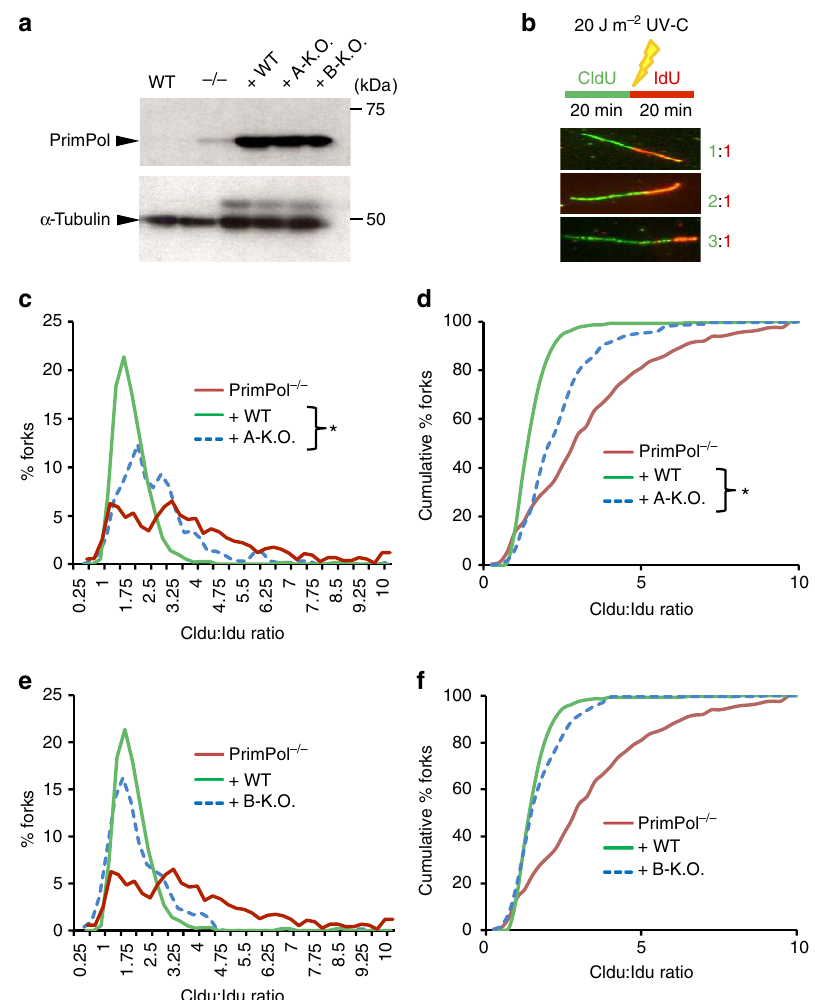
Figure 5 | RBM-A is required for PrimPol function in DNA replication restart. ( a ) PrimPol (cid:2) / (cid:2) DT40 cells were complemented with un-tagged human PrimPol constructs; wild-type hPrimPol ( þ WT), hPrimPol D519R/F522A ( þ A-KO) and hPrimPol D551R/I554A ( þ B-KO). ‘WT’ indicates lysate from wild-type DT40 cells, ‘ (cid:2) / (cid:2) ‘ indicates lysate from PrimPol (cid:2) / (cid:2) DT40 cells. ( b ) DNA fibre analysis was performed on DT40 cells expressing each PrimPol construct. Cells were ultraviolet-C irradiated (20Jm (cid:2) 2 ) between the CldU and IdU labelling periods (each 20min). Representative DNA fibres showing 1:1, 2:1 and 3:1 CldU:IdU ratios are presented; 4 100 individual DNA fibres were scored for each experiment. ( c ) Mutation of RBM-A causes increased fork